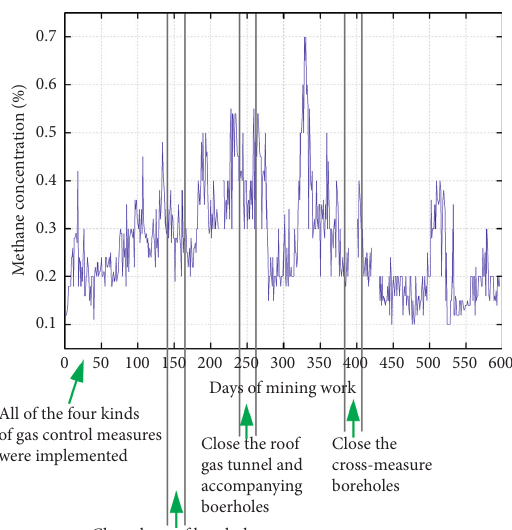
Figure 13: Variations of methane concentration in mining area when using different gas drainage measures in No. 2 1024